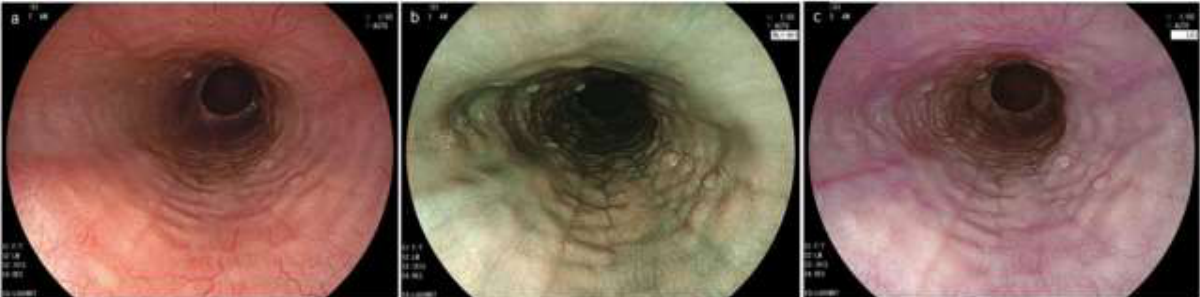
Figure 6. Endoscopic image sets consisting of WLI, BLI and LCI in EoE. ( a ) WLI; ( b ) BLI; ( c ) LCI ( a – c , same patient) . Rings and edema in the lower esophagus are more clearly visible in LCI compared to WLI and BLI. EoE, eosinophilic esophagitis; WLI, white light imaging; NBI, narrow band imaging; BLI, blue laser image; LCI, linked color imaging.